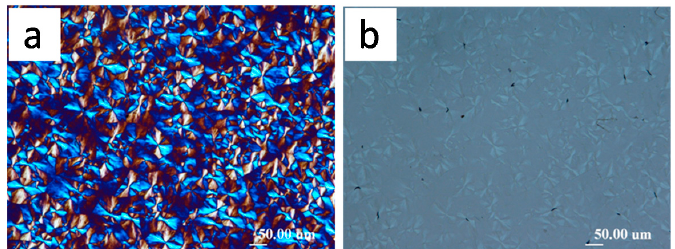
Figure 7. POM ( a ) and OM ( b ) micrographs showing no cracks (except for tiny cracks on nuclei centers) on small ringless spherulites of PHB/LM w -PLLA-11k blend isothermally crystallized at T c = 100 °C, with top cover, then cooled to ambient. Reprinted with permission from Ref. [20]. Copyright (2011) American Chemical Society.